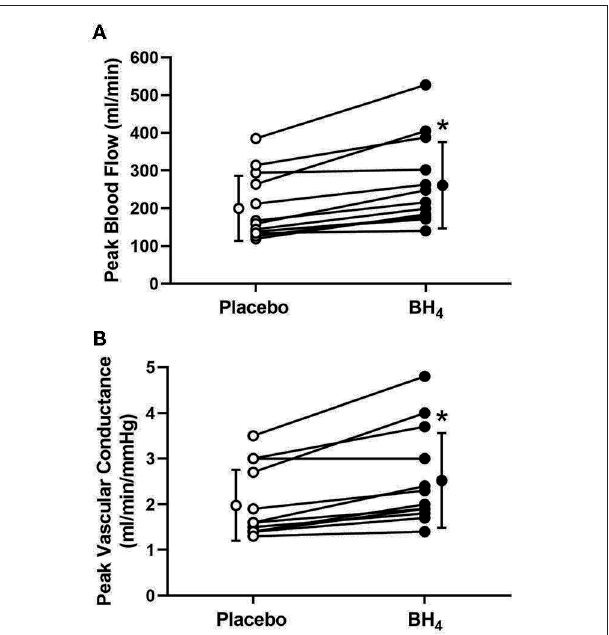
FIGURE 2 | Individual peak brachial artery blood flow (A) and vascular conductance (B) in response to progressive handgrip exercise in patients with systemic sclerosis after placebo (white circles) and tetrahydrobiopterin (BH 4 ; black circles). * P < 0.05, significantly different than placebo. Group data are presented as mean ± SD.